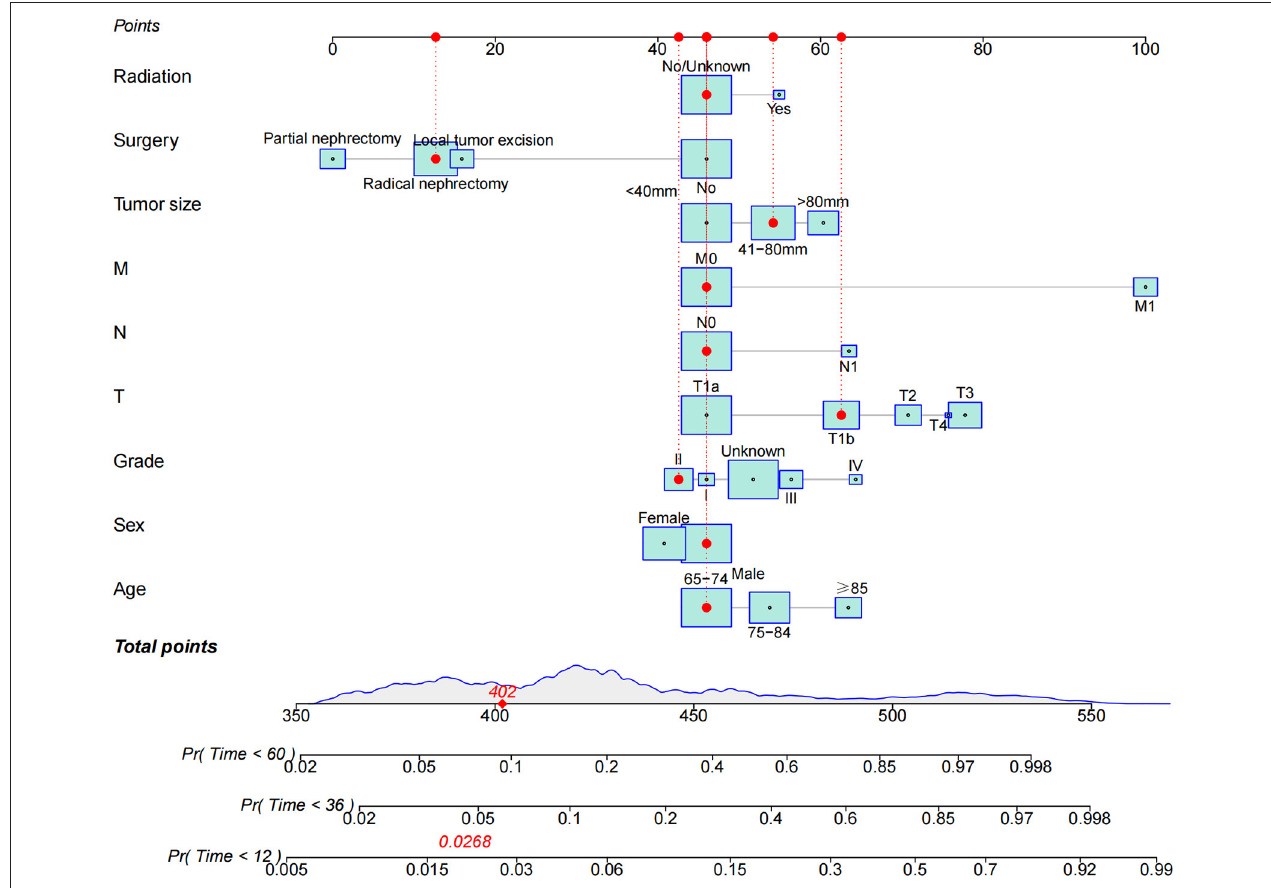
FIGURE 2 | The nomogram for predicting 1-, 3-, and 5-year CSS in elderly patients with